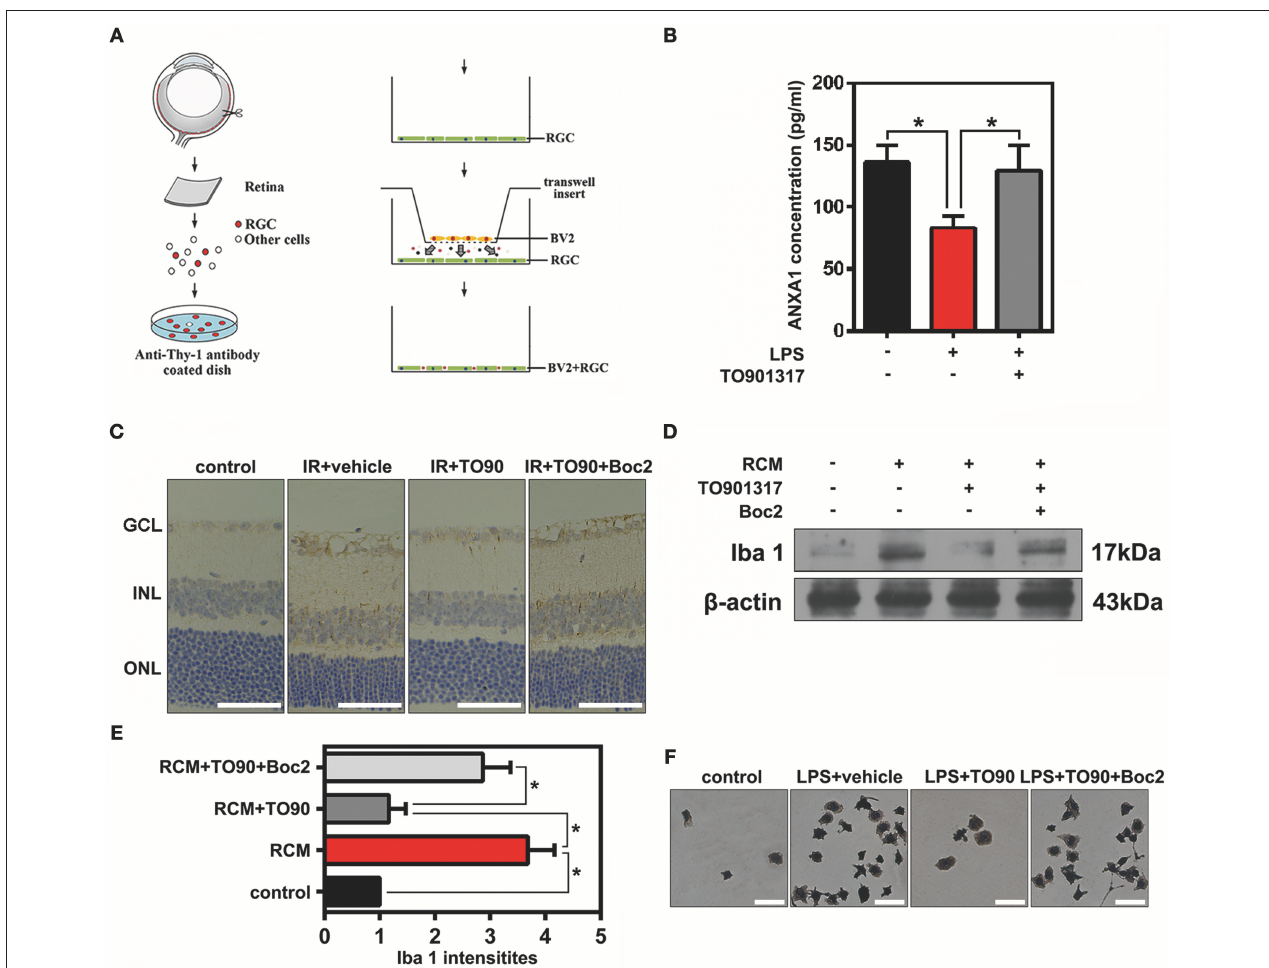
FIGURE 5 | The effects of TO901317 on microglial activation. (A) Schematic diagram of immunopanning and transwell migration assays. (B) ELISA results reveal that TO901317 leads to an increase of ANXA1 secretion in primary cultured RGCs. A one-way ANOVA with Bonferroni post hoc test was used. (C) Immunohistochemical results indicate that TO901317 suppresses the activation of microglia after IR in vivo , while Boc2 (10 µ M) reverses this effect ( n = 6 retinas per group). Scale bar = 50 µ m. (D) Western blotting analysis demonstrating that TO901317 reduces the expression of Iba1 in BV2 cells incubated with RCM. This effect is inhibited by Boc2. (E) Statistical analysis of the data shown in (D) . The data of three independent experiments are expressed as the means ± S.D. * P < 0.05, one-way ANOVA with Bonferroni post hoc test. (F) TO901317 inhibits microglial migration induced by LPS, and this effect is reversed by Boc2 (10 µ M). Scale bar = 20 µ